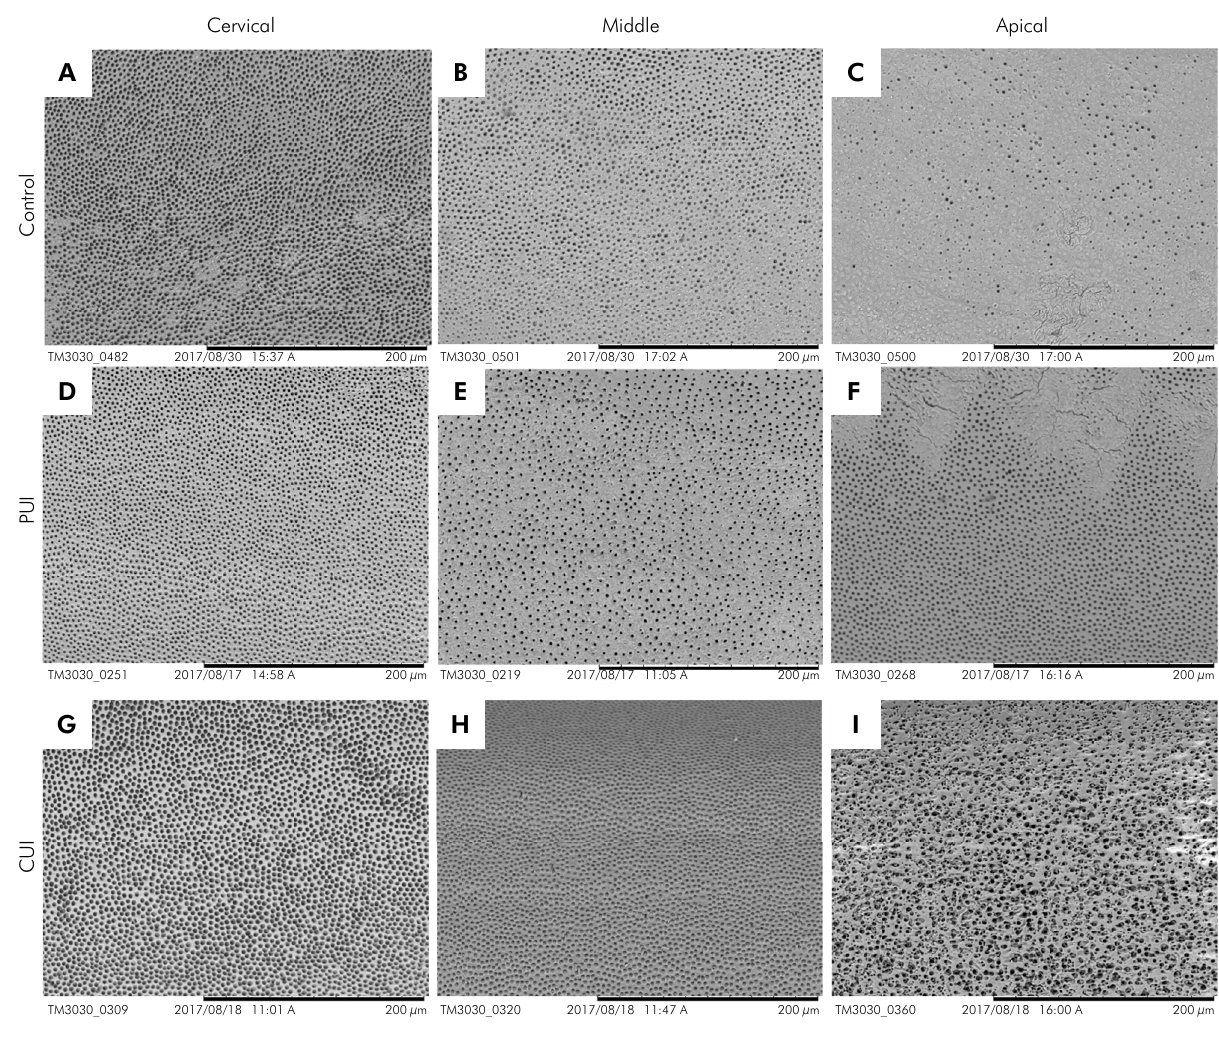
Figure 2. SEM images (500x) of representative samples from the apical, middle, and coronal thirds, illustrating the different irrigant activation techniques. Conventional irrigation (control) group (A-C) showing a clean wall with few smear plugs (arrows) at the coronal third, less open tubules with more smear layer at the middle third, and a thicker smear layer with few open tubules at the apical third, with smear layer evident in 50%–75% of the canal surface and tubules. PUI group (D–F) showing a clean wall at the coronal third, less open tubules with more smear layer plugs at the middle third, and a smear layer covering >25% of the canal wall and dentinal tubules at the apical third; CUI group (G-I) showing a highly clean canal surface with open dentinal tubules at the coronal, middle, and apical thirds, where most tubules are open and